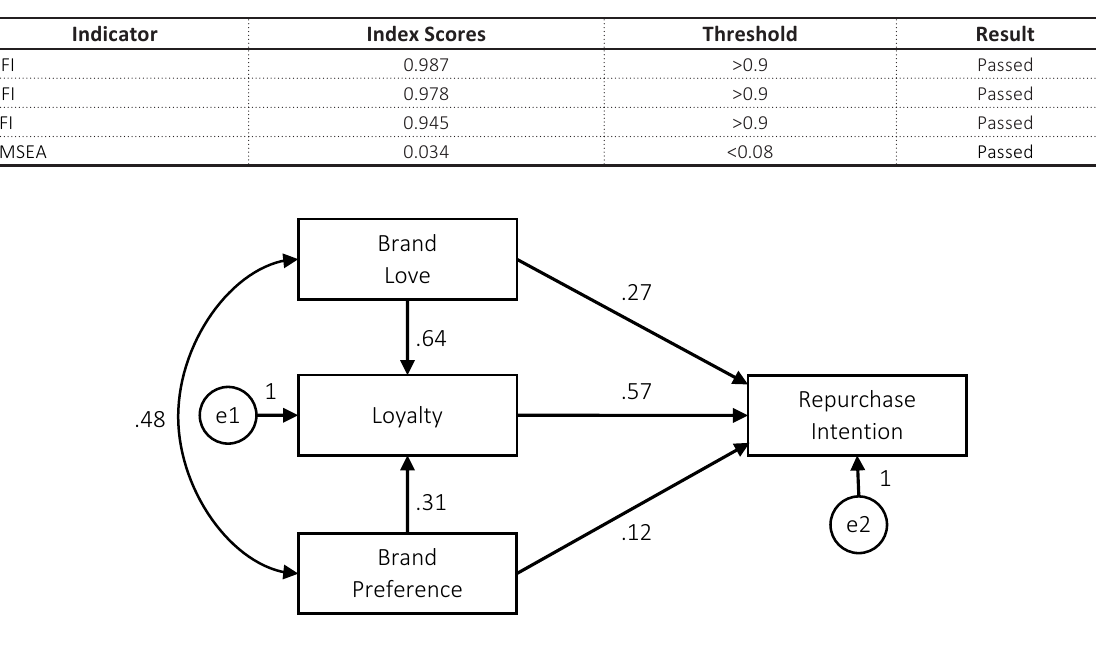
Table 3. Model fitness of path analysis